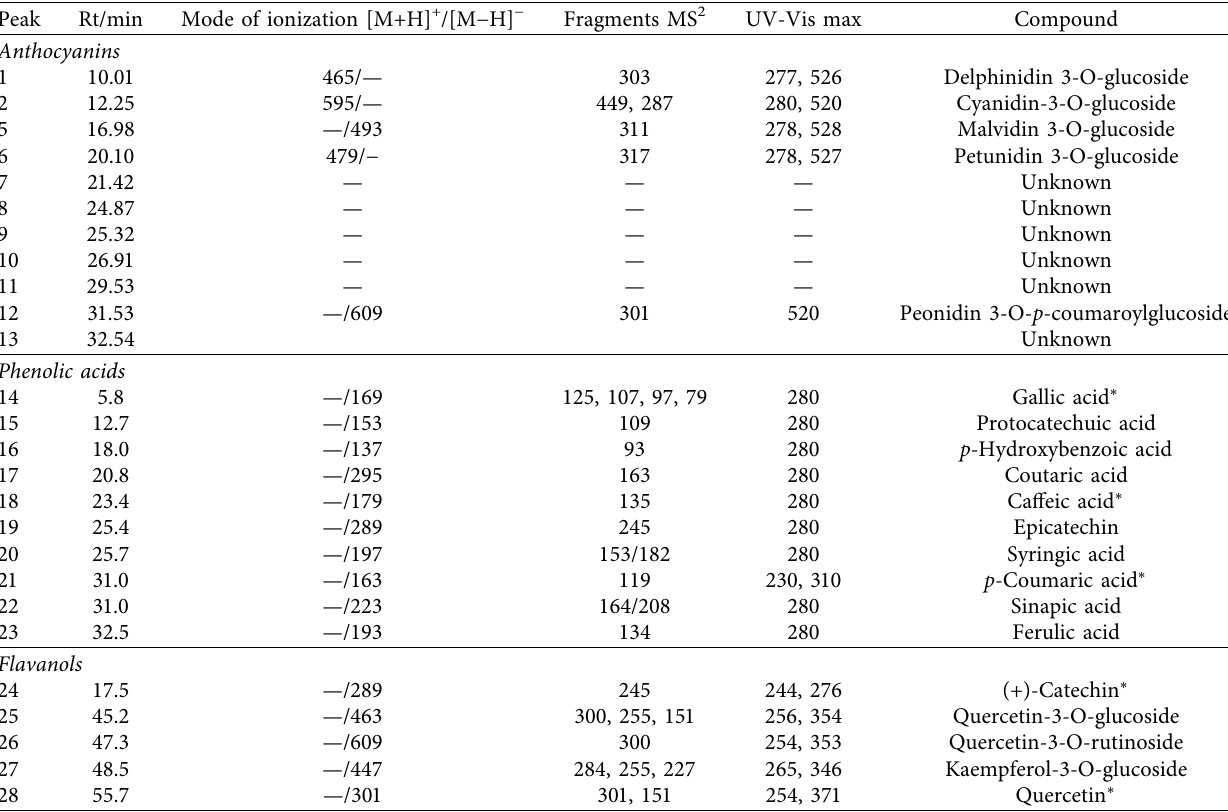
Table 4: Characterization of the main compounds of the grape pomace extract using their spectral characteristic in HPLC-DAD-MS. Peak